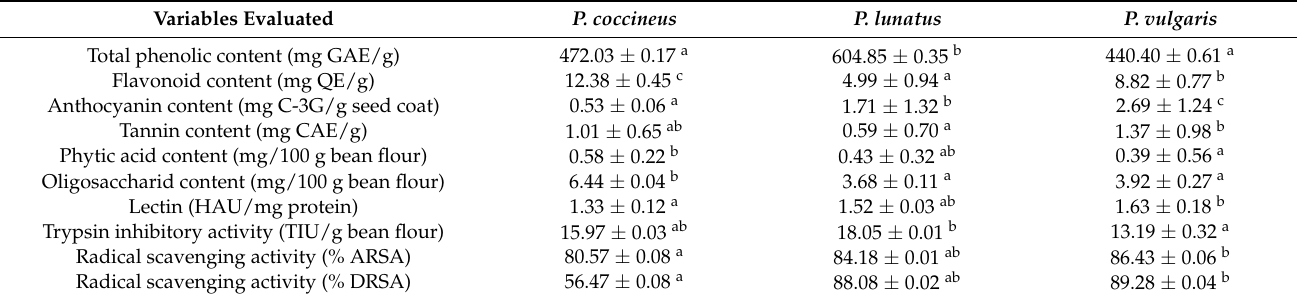
Table 3. Total phenolic, flavonoid, anthocyanin, tannin, phytic acid, oligosaccharide, lectin, trypsin inhibitory activity, and radical scavenging activity from Phaseolus accessions collected.